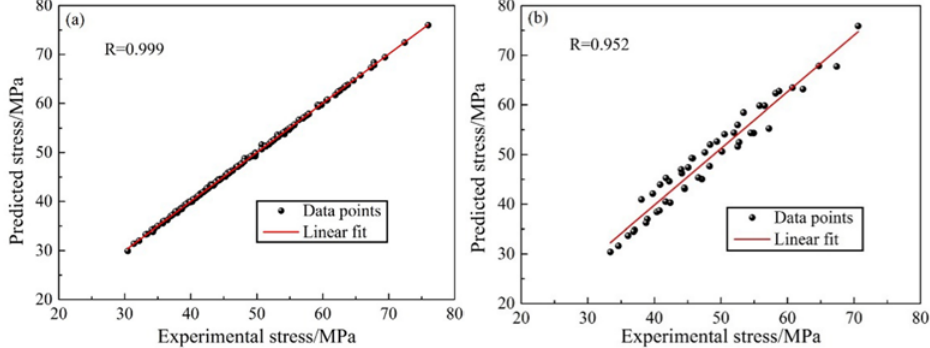
Figure 8. Comparison of flow stress values predicted by artificial neural network (ANN) model and experimental values for ( a ) training and ( b ) testing. Metals 2017 , 7 , 114